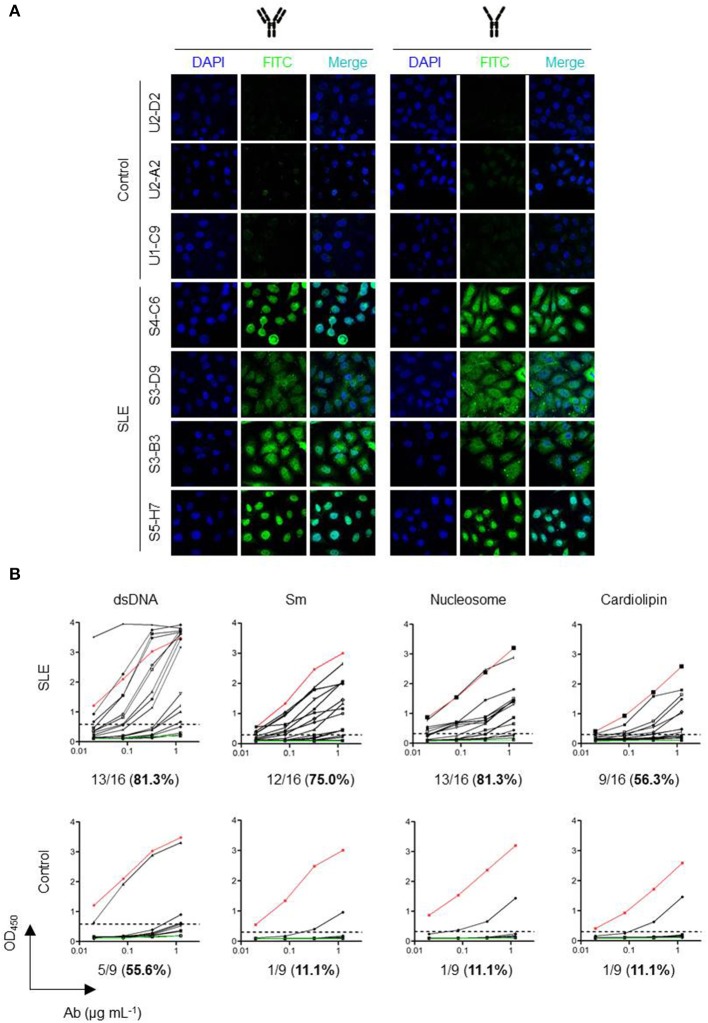
Many HCAbs from SLE patients are autoreactive. (A) Autoreactivity (ANA) of HCAb. HEp-2 cells were used as immunofluorescence targets. The nuclei were stained with DAPI. FITC-conjugated goat anti-human IgG was used as a secondary antibody. (B) Polyreactivity of HCAbs ELISA results of 25 HCAbs against double-stranded DNA (dsDNA), Smith antigen (Sm), nucleosome, and cardiolipin. The antibodies were used at 0.02, 0.078, 0.313, and 1.25 μg/mL. Red and green lines indicate positive and negative controls, respectively. Dashed lines represent the cut-off OD450 value for positive reactivity. Percentage in brackets refers to the positive rate.